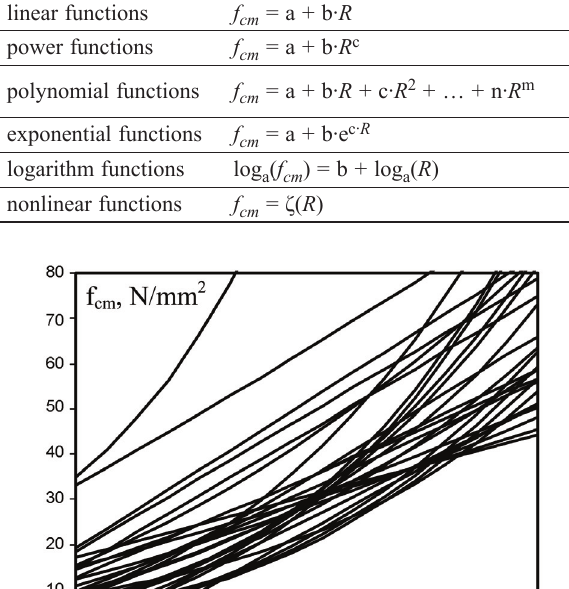
Table 1. Proposed regression function types for the rebound index vs. strength relationship linear functions